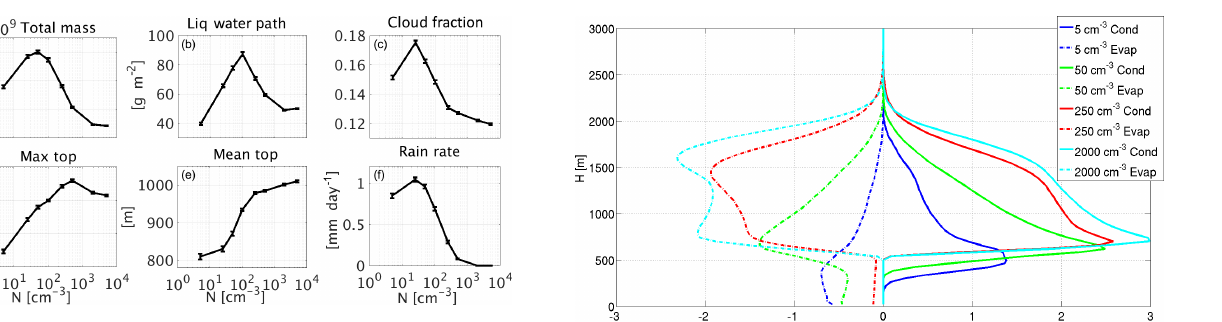
Figure 1. Mean properties (over domain and time) of the sim- ulated cloud fields as a function of the aerosol concentration used in the simulation: (a) total liquid water mass in the do- main, (b) cloudy LWP, (c) CF for columns with τ >0.3, (d) max- imum cloud top, (e) mean cloud top and (f) surface rain rate. Each of these mean properties are calculated for the last 14h of the 16h of simulation. The error bars present the standard errors. For details about the different properties see the text.